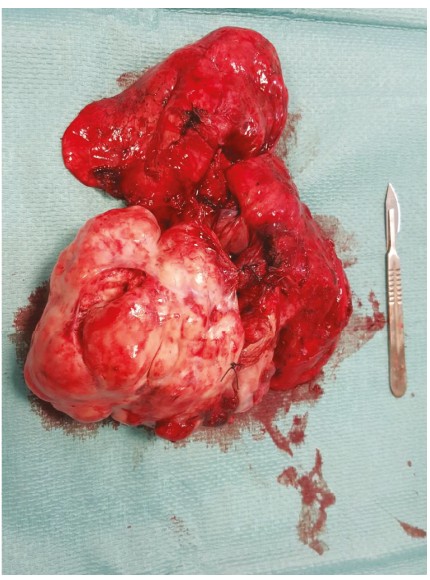
Figure 5: Pneumonectomy